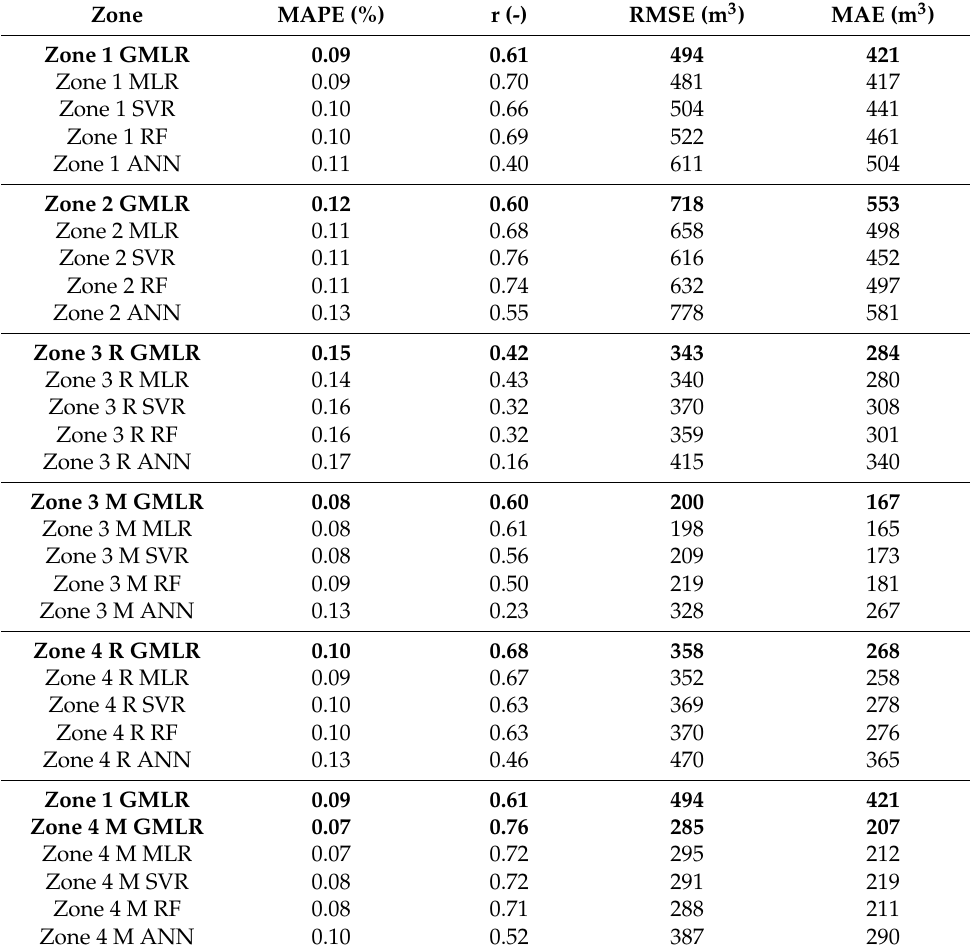
Table 3. Model accuracy for the test data set (2019) for all applied modeling approaches. The results from the GMLR model are highlighted in